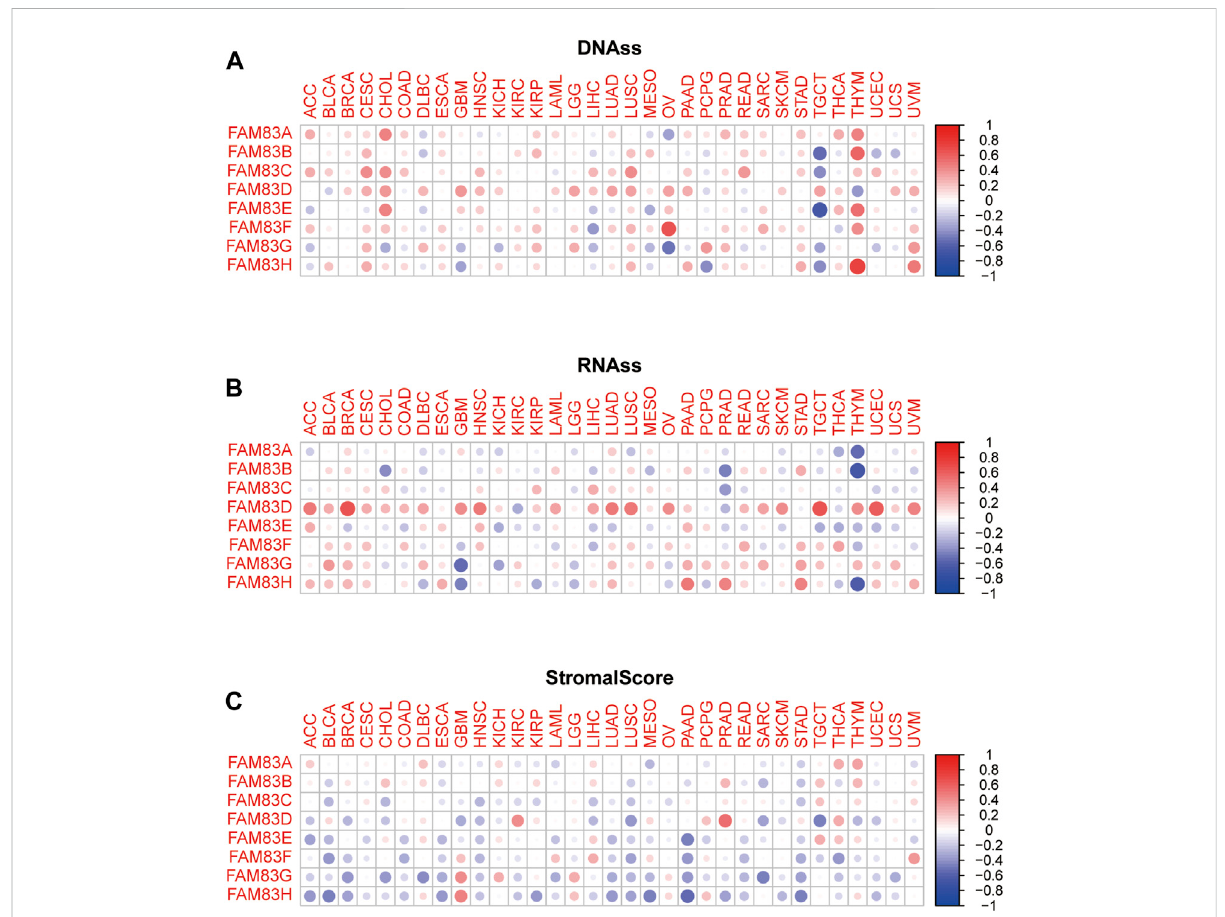
FIGURE 6 Relationship of FAM83 family gene expression levels with tumor microenvironment and stemness scores across cancers. (A,B) Heatmap of the correlationbetweenFAM83familygenesandRNAssandDNAss. (C) HeatmapofthecorrelationbetweenFAM83familygenesandStromalScore.The circle color indicates the correlation coef fi cient, red indicates a positive correlation, and blue indicates a negative